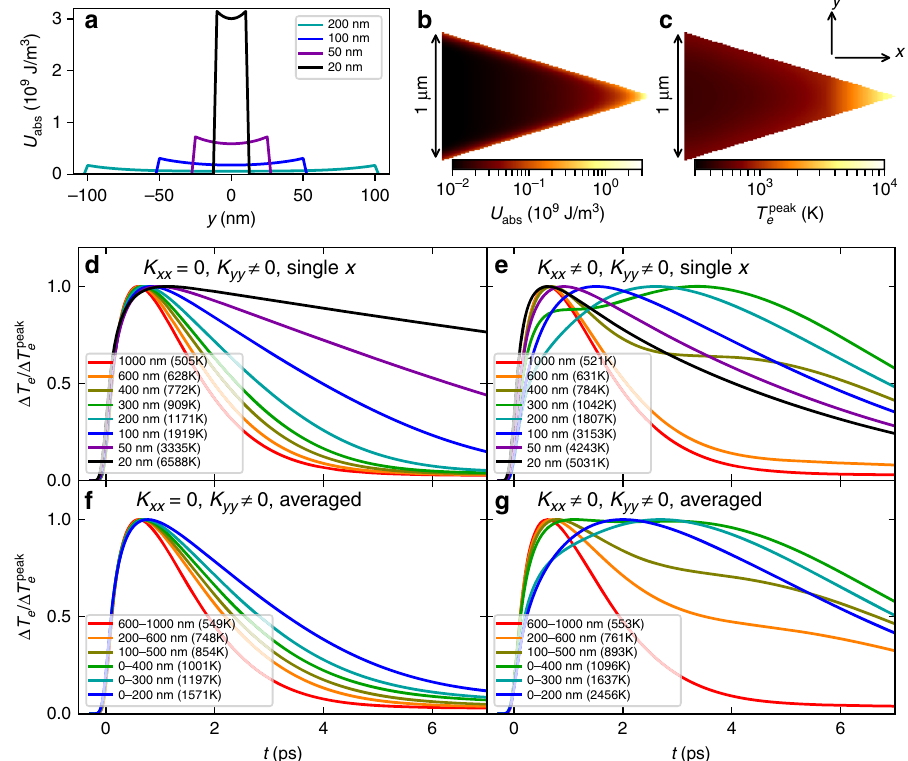
Fig. 5 Impact of spatial con fi nement and heat fl ow on the rising time. Computed absorbed energy-density pro fi le for an SPP at λ 0 = 800 nm assuming 1-nJ pump pulse energy ( a ) for four taper widths and b over an area of the taper close to the apex. c shows the corresponding peak electron temperature predicted by TTM simulations. d , e show the simulated temperature pro fi les at various widths accounting only for heat fl ow along y in d and fully accounting for both directions in e . f , g show the corresponding temperatures averaged over ranges of widths, to account for the fi nite size of the probe beam. To show the rise and fall times clearly, the temperature pro fi les in d – g are normalized to their peak temperatures, which are indicated in parenthesis in the legends. Comparing g – f shows that heat fl ow from the apex with enhanced absorption due to SPP slowdown is responsible for the observed increase in rising